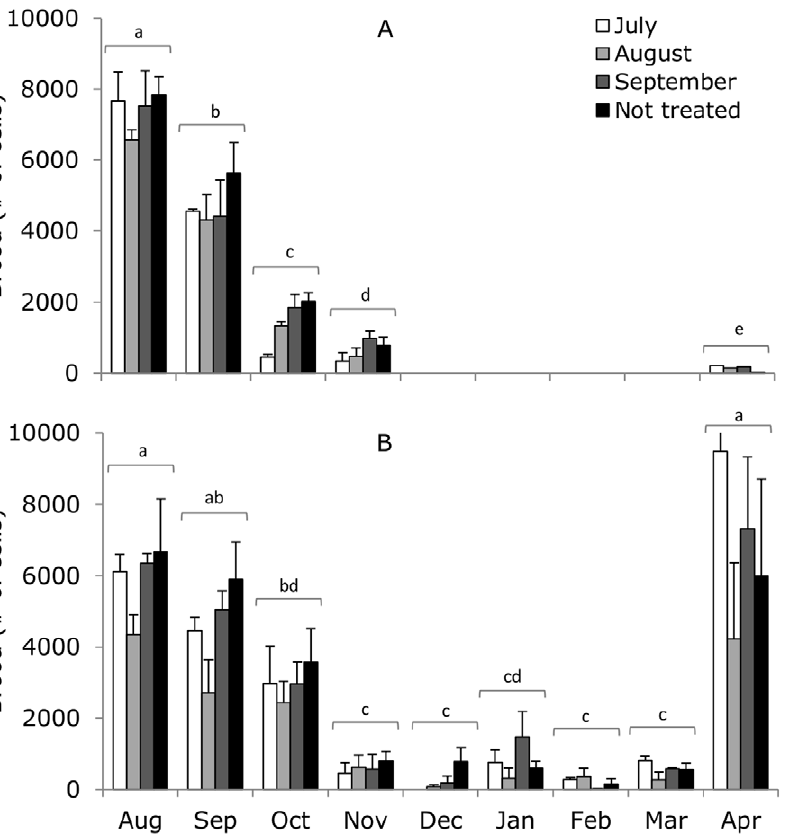
Figure 5. Mean number of capped brood cells in 2005/2006 (A) and 2006/2007 (B). Colonies were treated with Thymovar H in July (white bars), August (grey bars), September (dark grey bars), or not treated at all (black bars). Number of capped brood cells between December 2005 and March 2006 were not measured due to cold winter temperatures. Letters show significant differences between months.